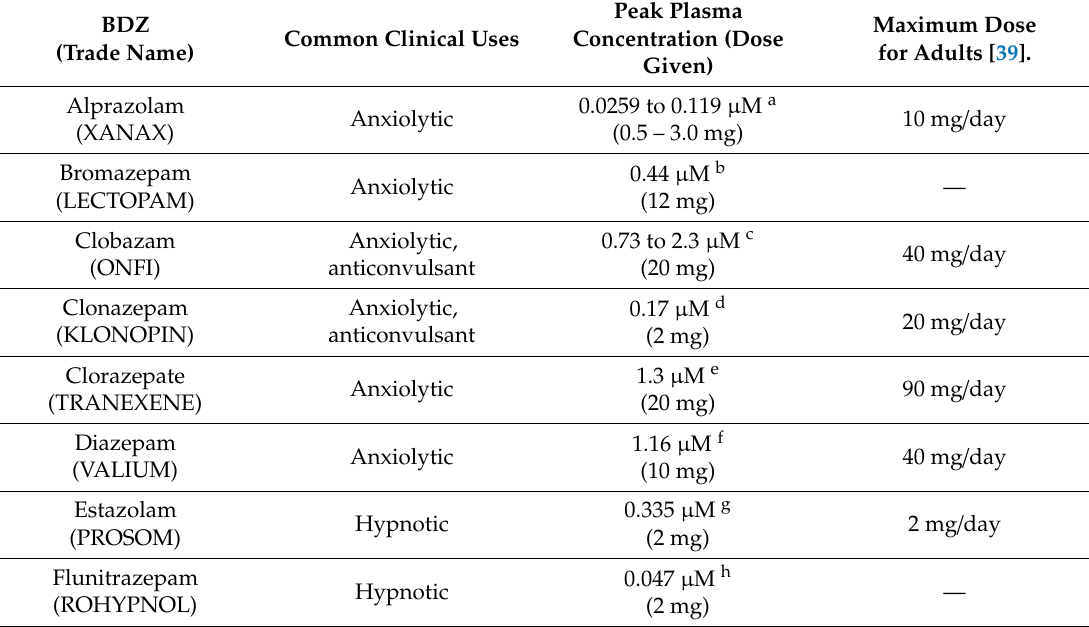
Table 1. List of tested clinically approved BDZs, a [42], b [43], c [44], d [45], e [46], f [47], g [48], h [49].